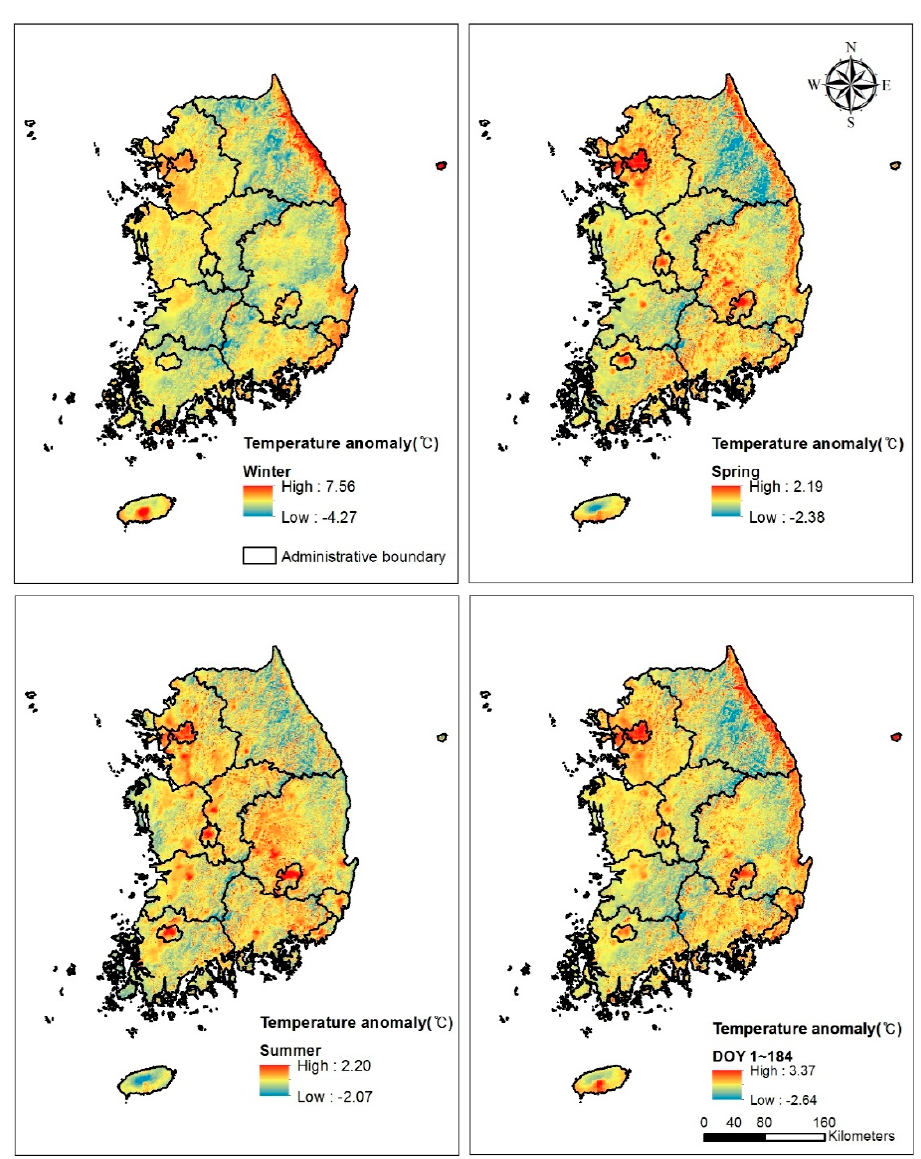
Figure 11. The spatial distribution of air temperature anomalies during winter ( upper left ), spring ( upper right ), summer ( lower left ), and DoY 1~184, 2015 in South Korea ( lower right ).